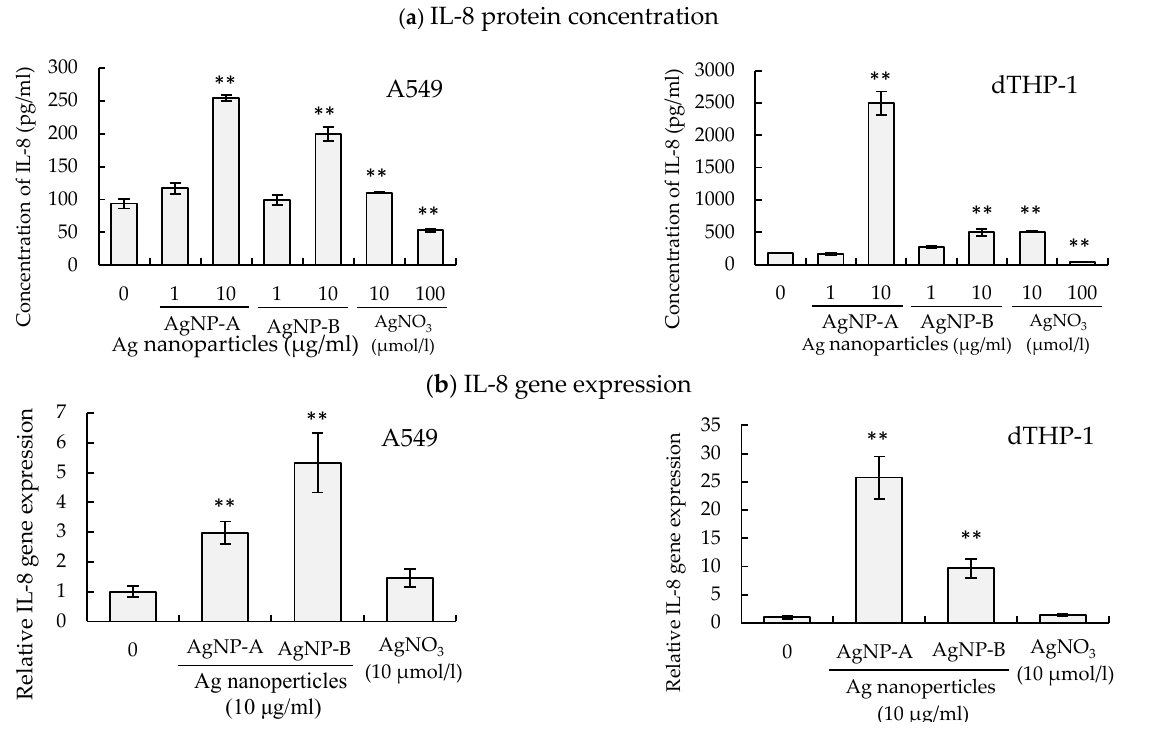
Figure 4. Regulation of IL-8 expression by AgNPs and AgNO 3 . ( a ) IL-8 protein concentration in culture supernatant. A549 and dTHP-1 cells were exposed to AgNP suspensions at 1 and 10 µ g/mL or AgNO 3 at 10 µ mol/L. After incubation for 24 h, the culture supernatant was collected, and the level of IL-8 was determined by ELISA. ( b ) IL-8 gene expression. A549 and dTHP-1 cells were treated with AgNP suspensions at 10 µ g/mL or AgNO 3 at 10 µ mol/L. After incubation for 24 h, IL-8 gene expression was determined by real-time PCR. ** p < 0.01 (vs. untreated cells, ANOVA and Dunnett’s test).